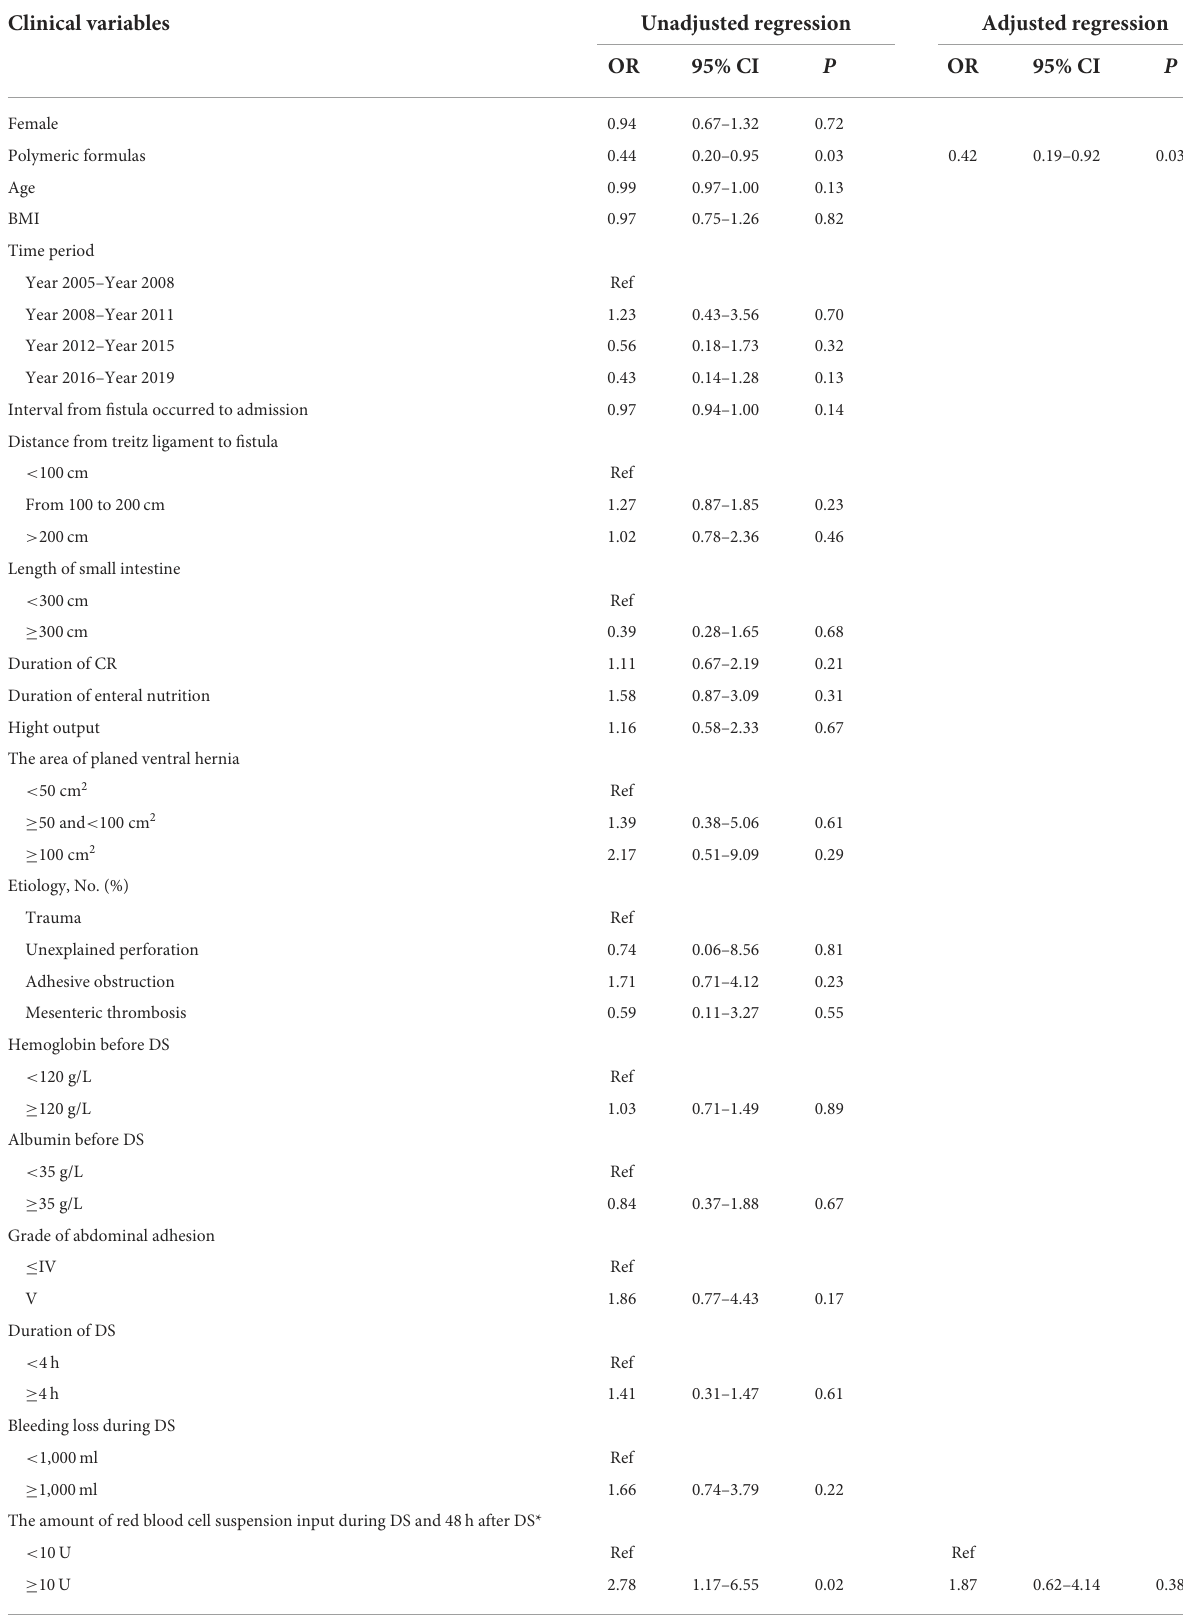
TABLE 3 Logistics regression analysis of the risk factors for postoperative ileus after